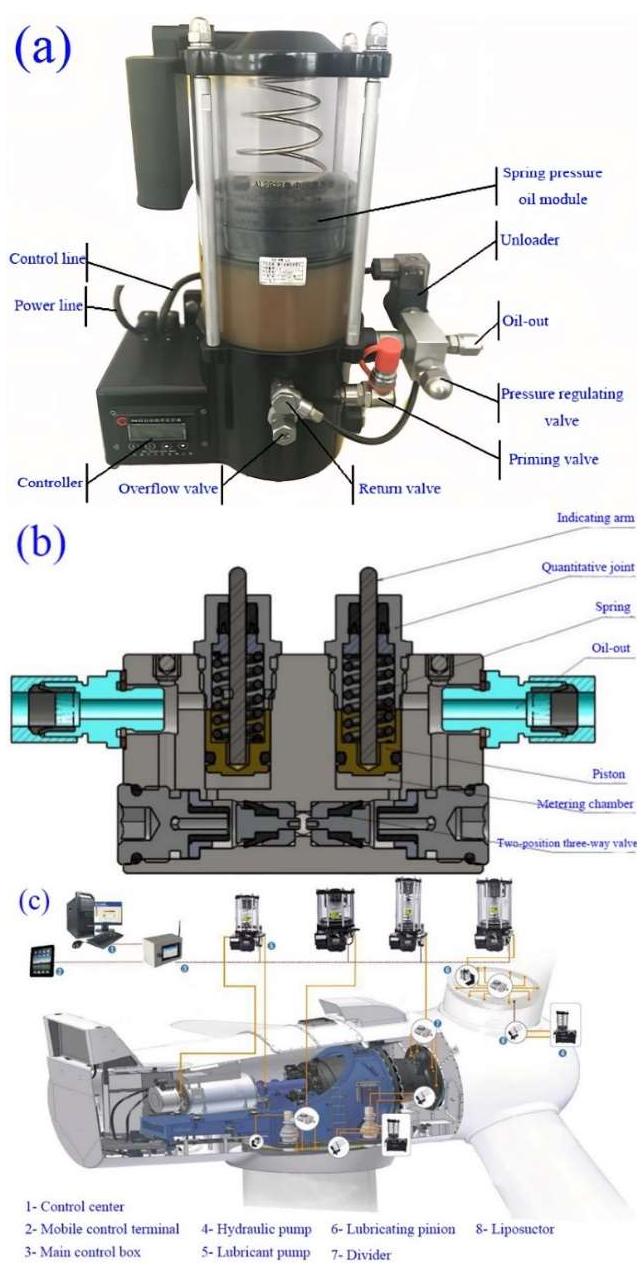
Figure 2. Physical structure of high-pressure lubricating pump station ( a ); dispenser structure with indicator rod ( b ); the centralized lubrication scheme of wind turbine ( c ) [27].